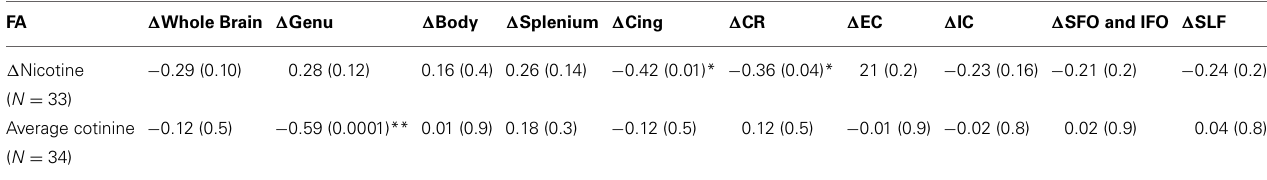
Table 3 | Correlation coefficients for the (cid:2) whole-brain and (cid:2) tract-wise FA value and (cid:2) nicotine and average cotinine levels for the discovery